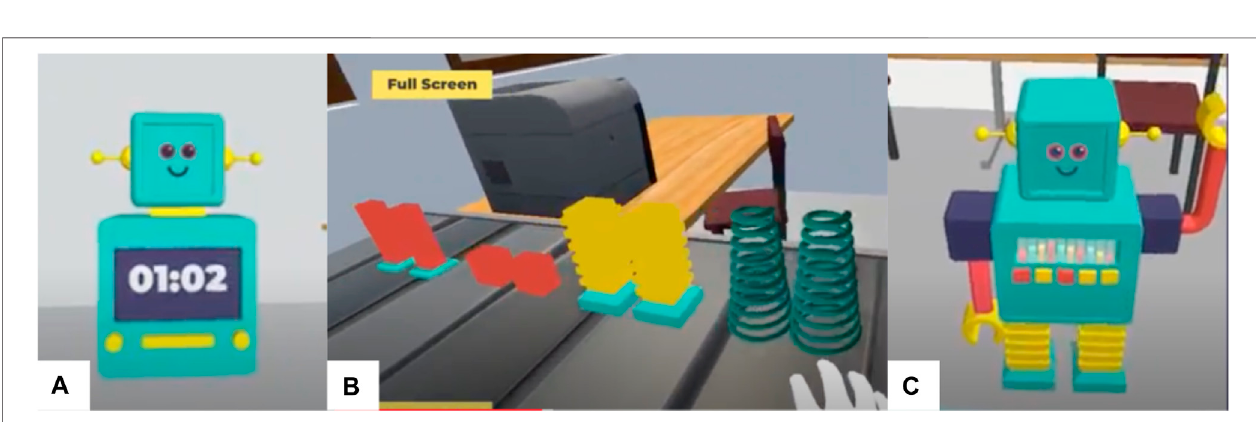
FIGURE 5 | Screen shots of objects in the mid- fi delity VR Robot Designer game. (A) The robot clock in the game to help encourage rapid prototyping. (B) The conveyor belt with various robot leg options. (C) A completed robot design.